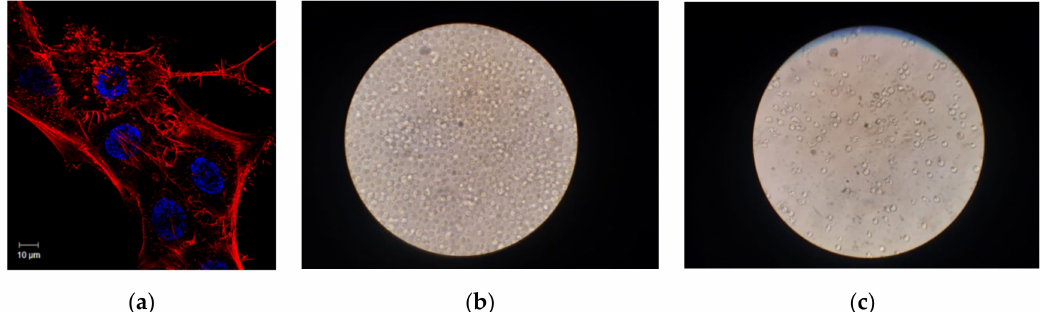
Figure 8. ( a ) Confocal image of the human osteoblasts cells studied. The red fluorescence was provided in actin cytoskeleton by rhodamine-phalloidin, while cells nuclei stained by DAPI were detected in blue emission. ( b ) Optical micrograph of the Raji cells studied before laser ablation. ( c ) Raji cells after laser ablation